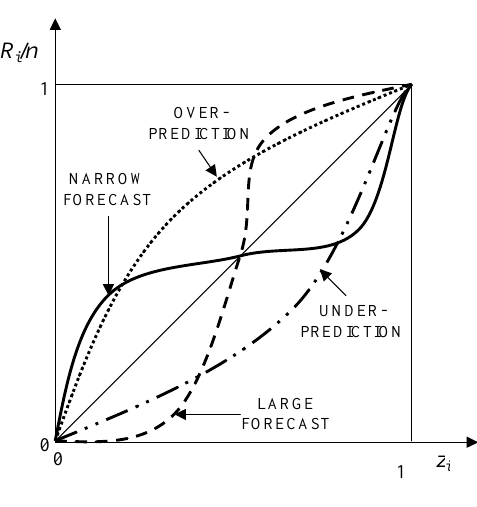
Fig. 2. Examples of the possible outcomes of a probability plot representation of the z i = P i (x i ) values versus their corresponding ranks R i (divided by the sample size n ). If the points lie close to the bisector, the forecast is deemed reliable; otherwise, a problem with the spread of the probabilistic forecast, or a prediction bias, are